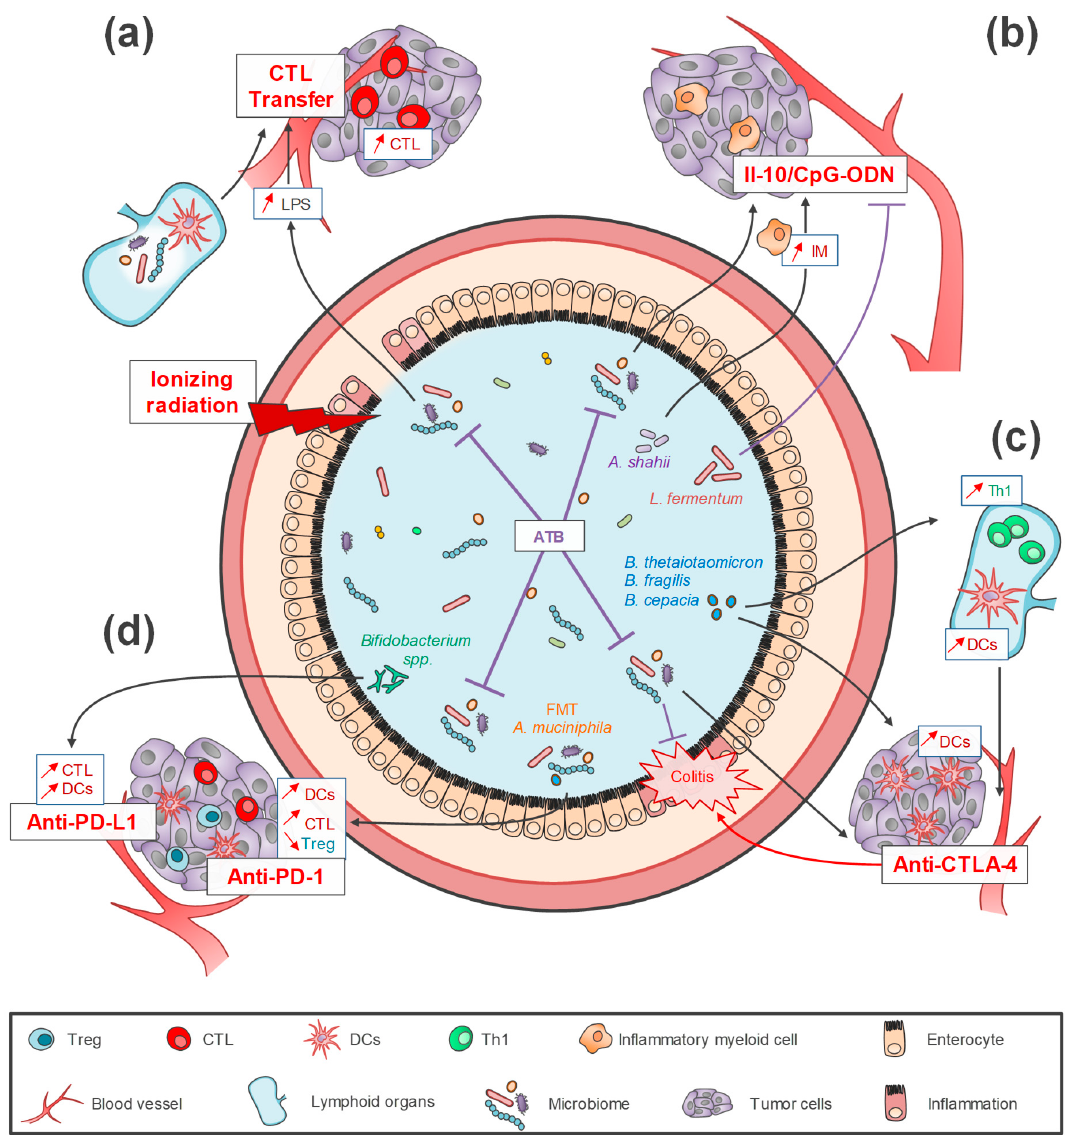
Figure 2. Impacts of intestinal microbiota on efficacy and toxicity of immunotherapy strategies. ( a ) Efficacy of anti-tumor CD8+ T cells (CTL) adoptive transfer (CTL transfer) has been stimulated by gut bacteria translocation into mesenteric lymph node and an increase of systemic LPS concentration induced by the total body irradiation in the murine model. This stimulation has been associated with an increase of CTL recruitment into a tumor microenvironment. ( b ) A decrease of gut bacterial load